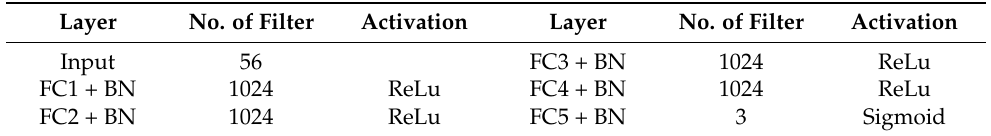
Table 1. Fully-connected NN